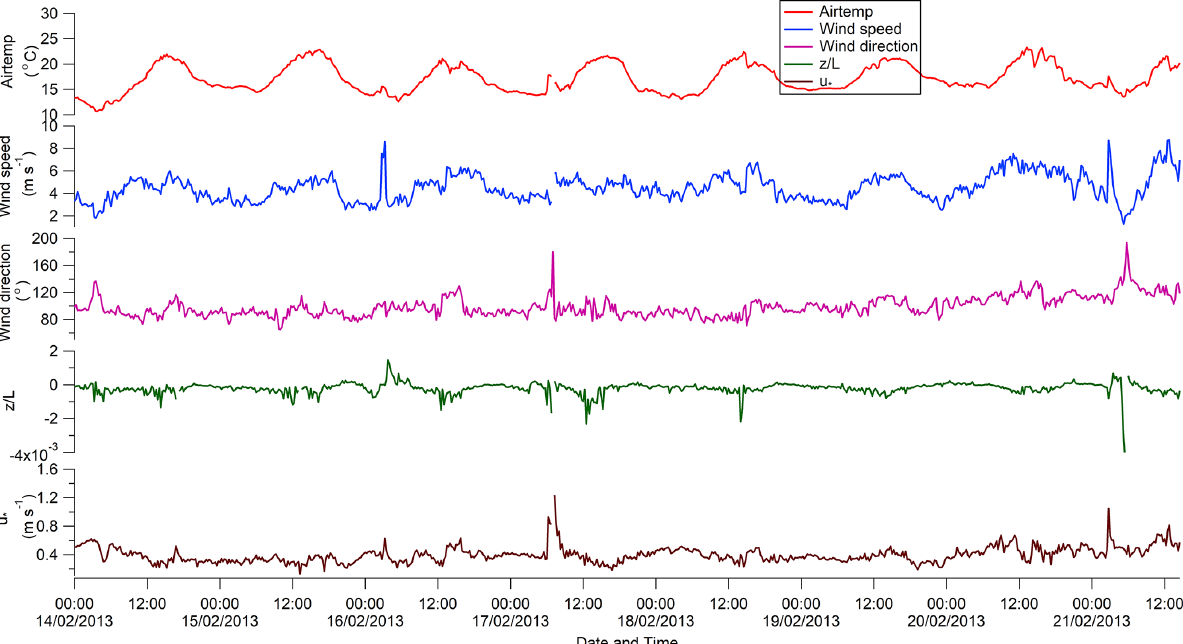
Figure 2. Ambient temperature (Airtemp), wind speed, and wind direction measured during the study. The atmospheric stability parameter ( z/L ) and wind friction velocity ( u ∗ ) are also plotted.